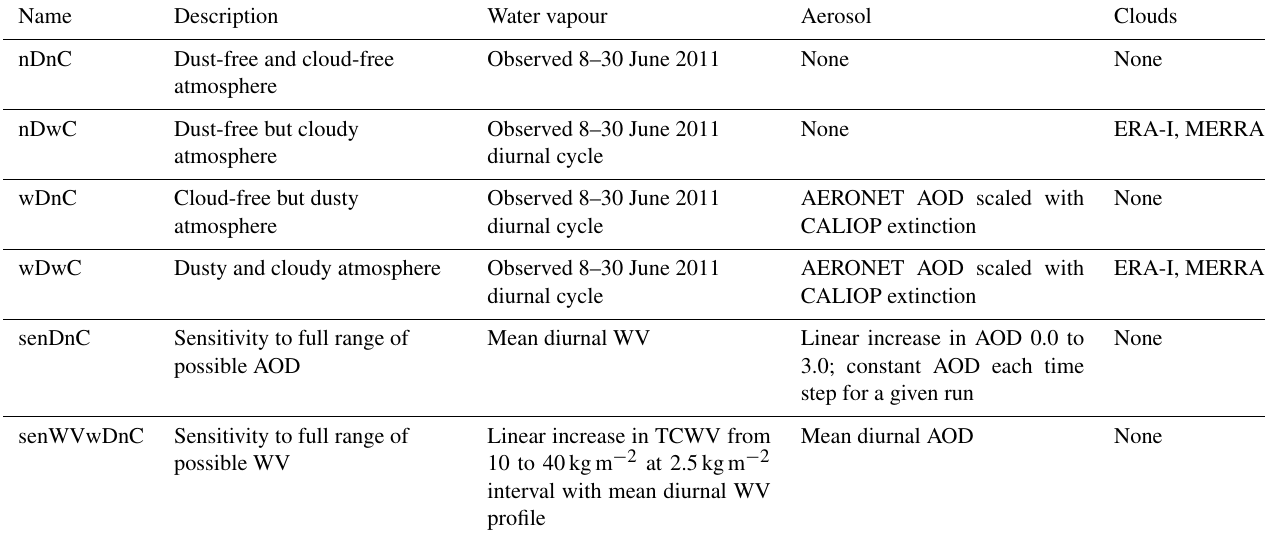
Figure 7. AOD from AERONET and SEVIRI, and column-integrated water vapour from Fennec observations. Grey shades show the driest days (11, 12, and 16), blue shades show the most humid days (18, 25, and 30), and green shades show a major haboob event that occurred on the 21 June 2011 which resulted in large dust emission. Table 1. Description of the RT “experiment mode”. Names of different experiments acronyms are defined as “n” for without, “w” for with, “D” for dust, “C” for clouds, “WV” for water vapour, and “sen” for